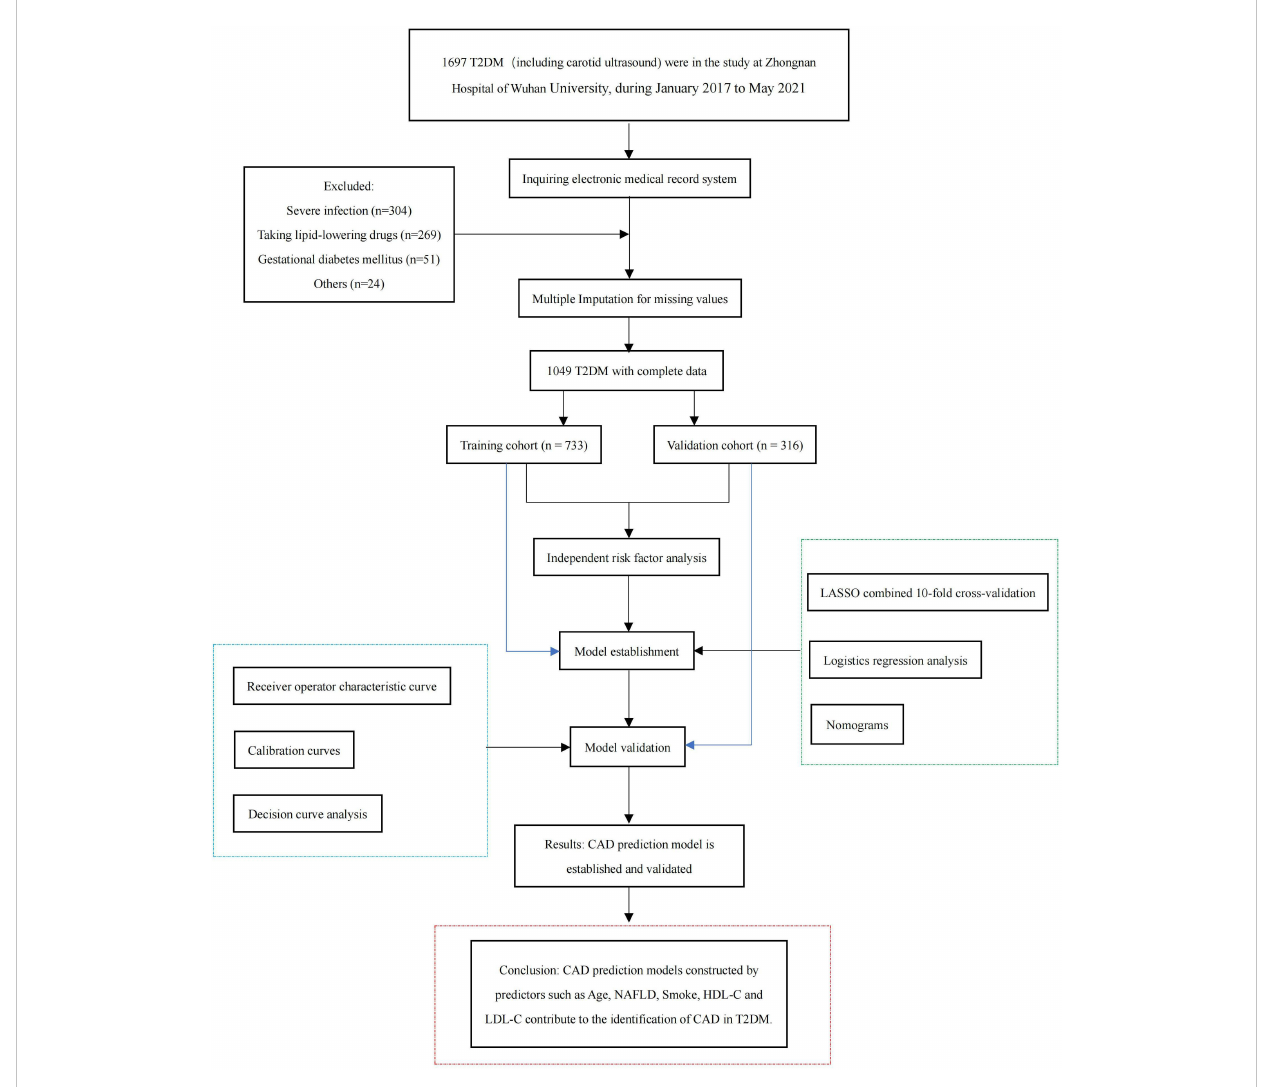
FIGURE 1 Flowchart of the